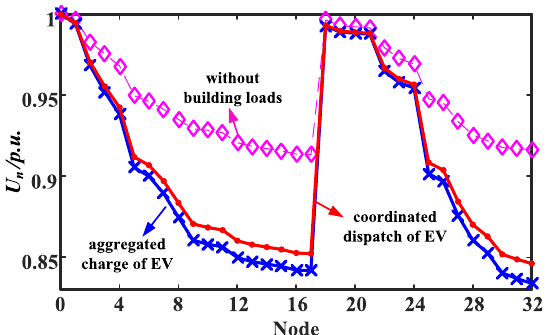
Fig. 8 Voltage curves under two operation modes of EV